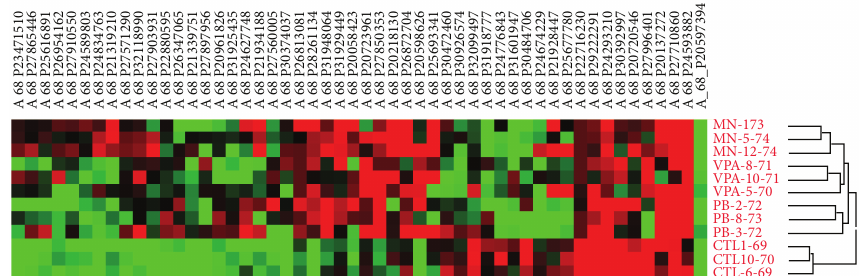
Figure 4: Mouse CpG Island Microarray for altered histone methylation. Hierarchical clustering of the untransformed data was done using Average Linkage (UPGMA) with similarity represented by Euclidean Distance. Data filtering: the genomic results were filtered from the UCSC (http://genome.ucsc.edu/) Mouse Genome Browser Gateway (NCBI37/mm9) for being within a CpG island and 5 󸀠 of a known gene. The samples clustered according to the treatment type.